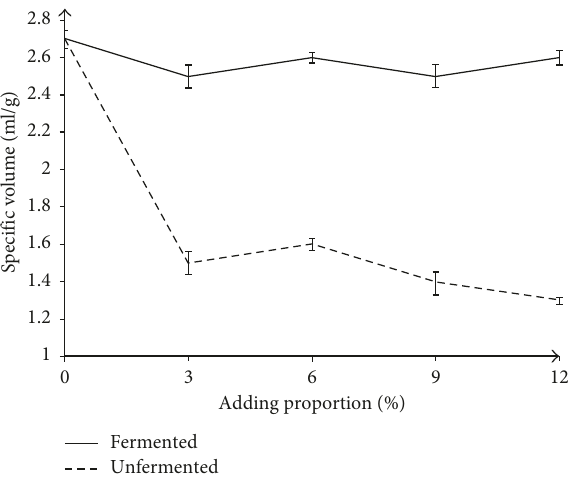
and G Figure 5: The effect of bran addition on the specific volume of steamed ′ ″